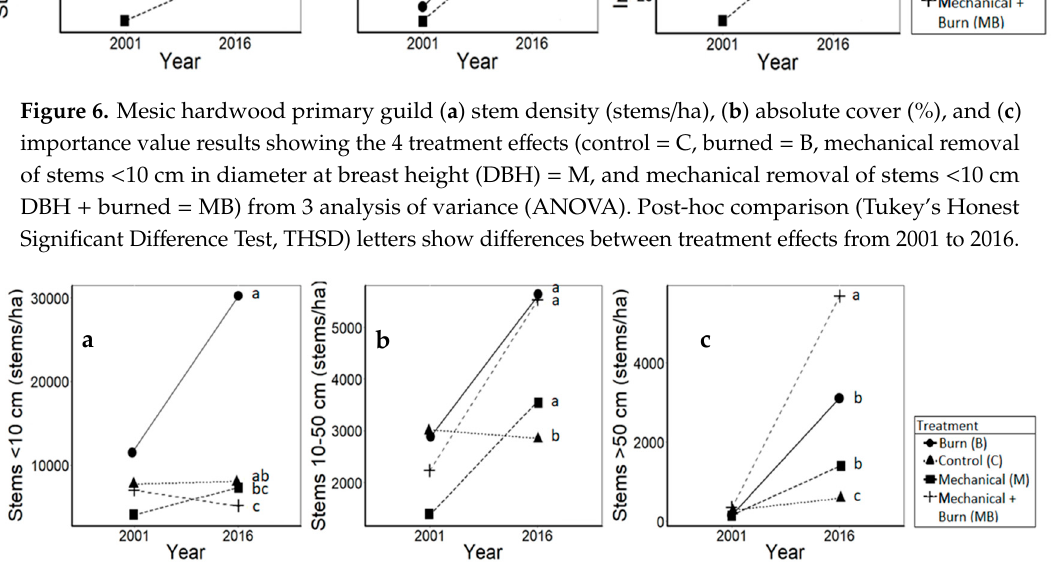
Figure 7. Mesic hardwood primary guild stem density results for stems ( a ) < 10 cm, ( b ) 10–50 cm, and ( c ) > 50 cm in height showing the 4 treatment e ff ects (control = C, burned = B, mechanical removal of stems < 10 cm in diameter at breast height (DBH) = M, and mechanical removal of stems < 10 cm DBH + burned = MB) from 3 analysis of variance (ANOVA). Post-hoc comparison (Tukey’s Honest Significant Di ff erence Test, THSD) letters show di ff erences between treatment e ff ects from 2001 to